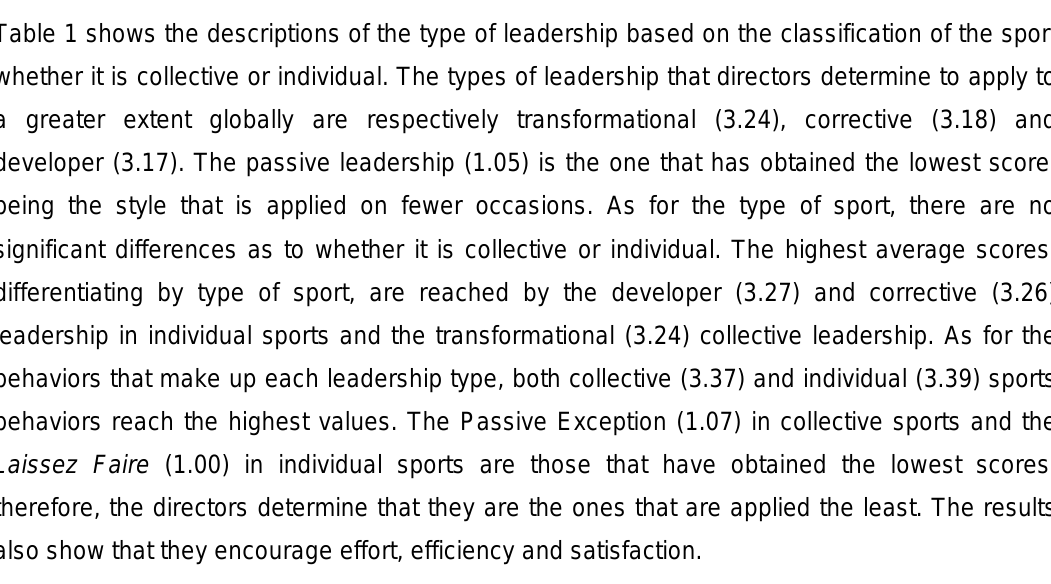
Table 1. Description of the type of leadership depending on the type of sport: collective-individual.